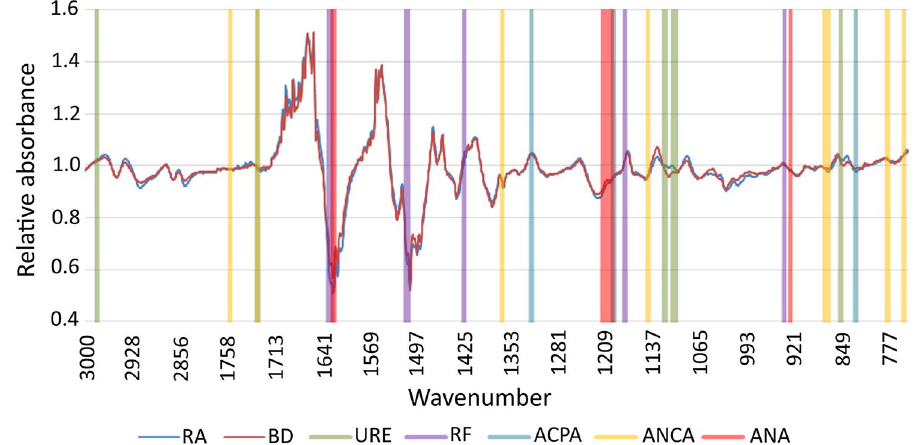
Figure 2. Best predictors characteristic of the examined antibodies, as calculated by the chi2